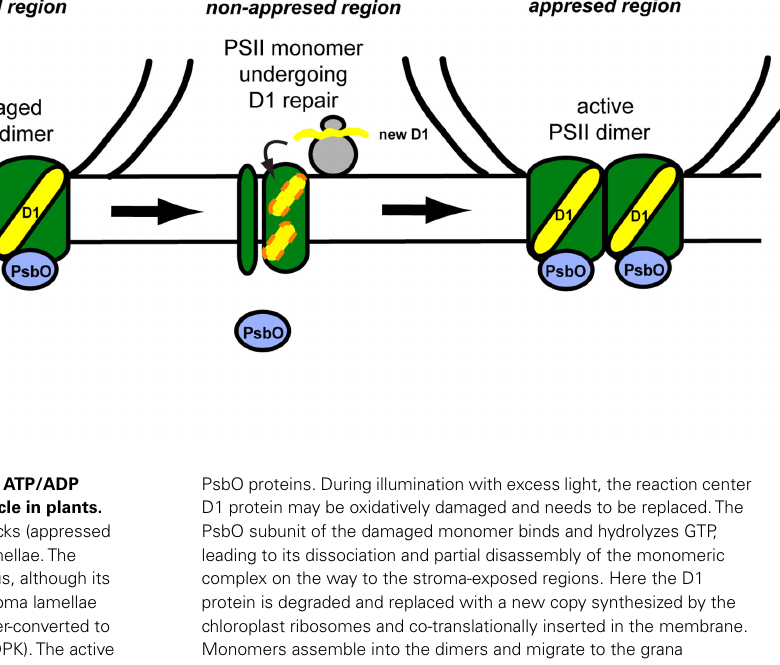
FIGURE 4 | Proposed model for role of the thylakoidATP/ADP carrier (TAAC) during photosystem II (PSII) repair cycle in plants. The plant thylakoid membrane is organized in grana stacks (appressed region) and stroma-exposed (non-appressed region) lamellae.The composition of the thylakoid membrane is heterogenous, although its lumenal space is continuous.TAAC is located in the stroma lamellae and exchanges stromal ATP for lumenal ADP. ATP is inter-converted to GTP by the lumenal nucleoside diphosphate kinase (NDPK).The active PSII dimer is located in the grana regions and contains lumenal extrinsic